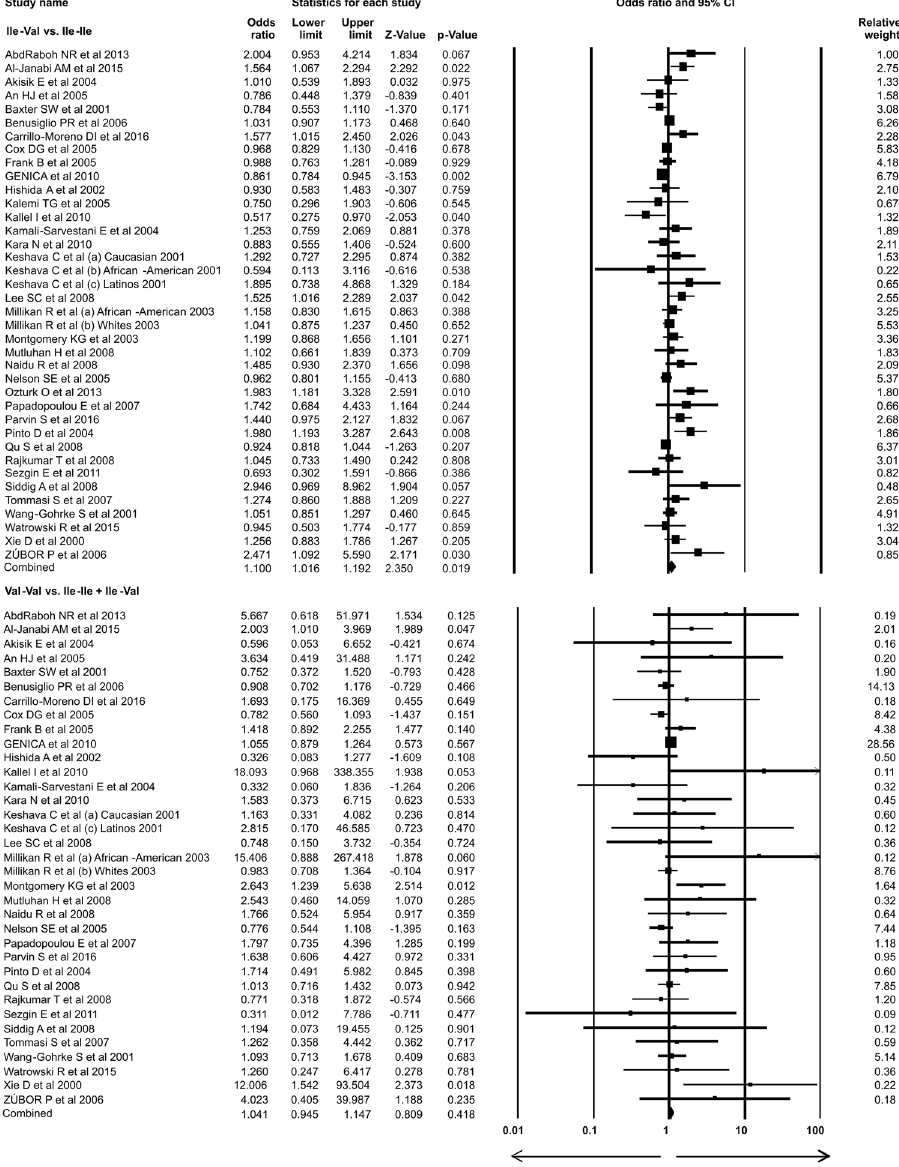
Figure 2. Forest plot: Genotypic (Heterozygous: Ile-Val vs Ile-Ile and Recessive: Val-Val vs. Ile-Ile + Ile-Val) analysis of Her2 Ile 655 Val (rs1136201) gene polymorphism and investigation of it’s association with breast cancer risk using OR with 95%